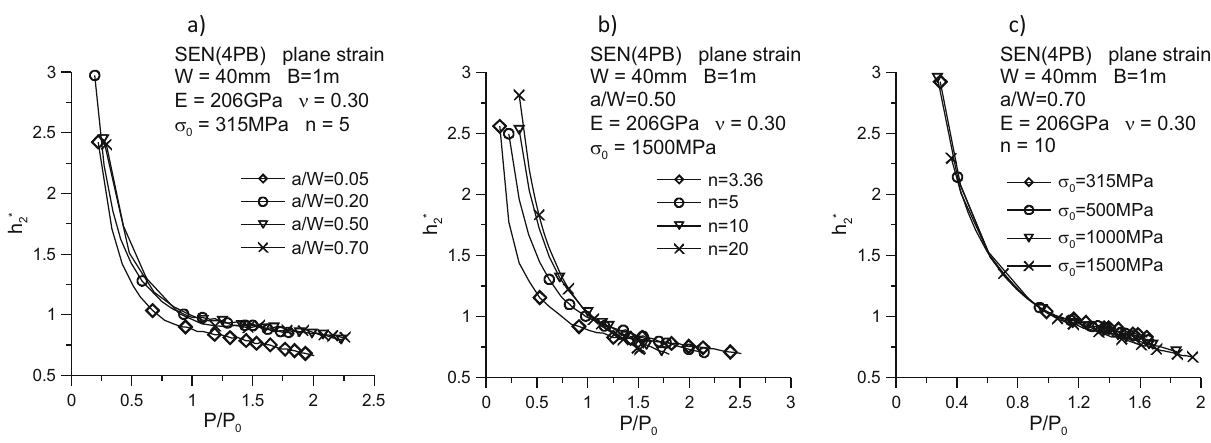
Figure 8: In fl uence of the relative crack length a / W ( a ) , the strain hardening exponent n in the R – O law ( b ) , and the yield point σ 0 ( c ) on the value of the h 2⁎ function for the entire external